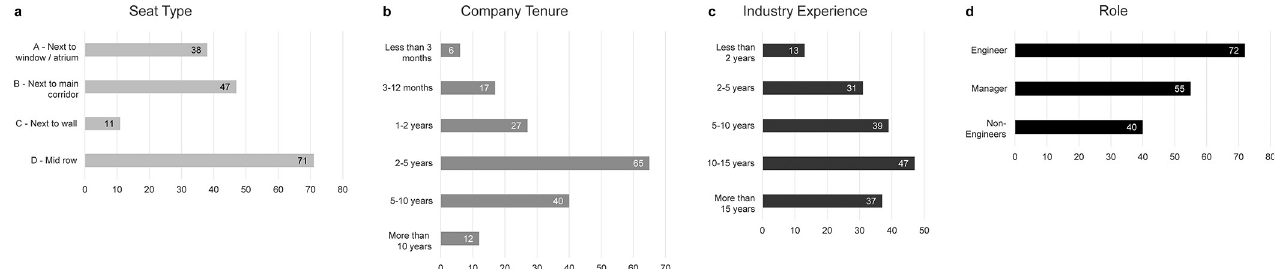
Fig 3. Distribution of categorical variables for study participants. a) Seat Type; b) Company Tenure; c) Industry Experience; d) Role. Roles were aggregated from more detailed role descriptions; non-engineers included roles such as administrators, specialists, data analysts, etc. The final sample size for which we have complete data is n =